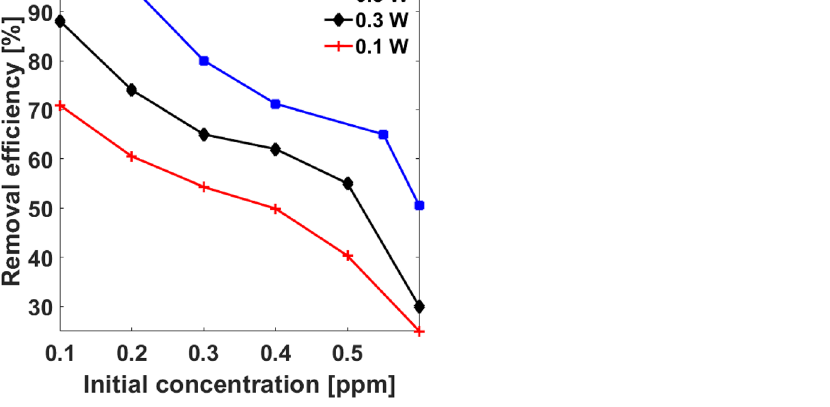
Figure 5. Effect of initial HCHO concentration on removal efficiency at different discharge